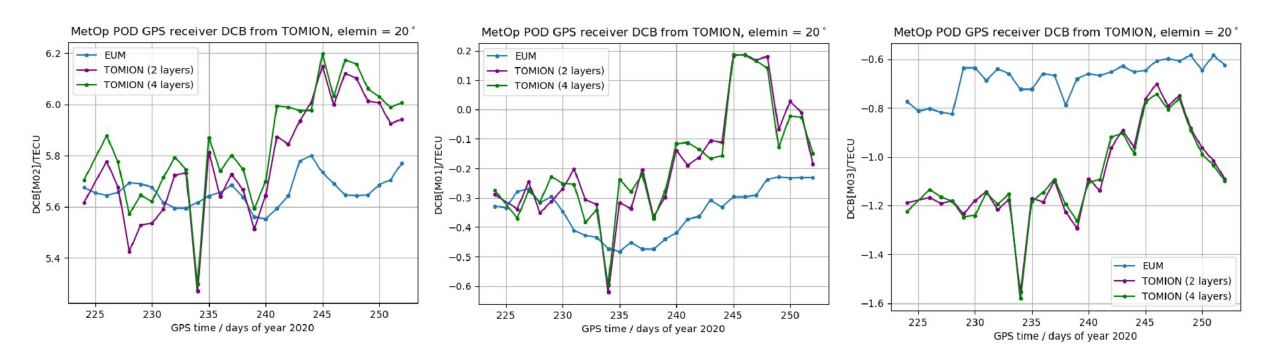
Figure 2. Daily values of the MetOp POD GPS receiver DCBs, in TECUs, from left to right, DCB[meta], DCB[metb], DCB[metc], in TECU, vs. day of year 2020, computed with TOMIONv1 with MetOp GPS data only under 2-layer TOMION run (green points), under 4-layer TOMION model (magenta points) and with the updated EUMETSAT technique